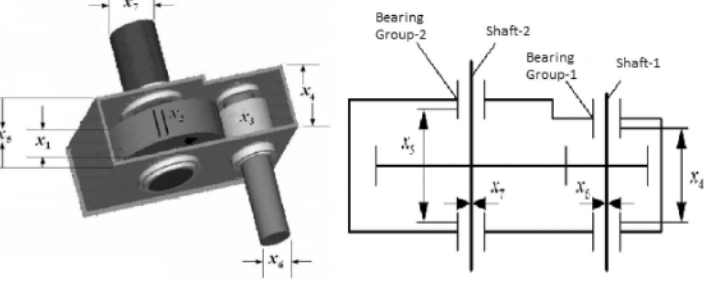
Figure 2. Speed reducer